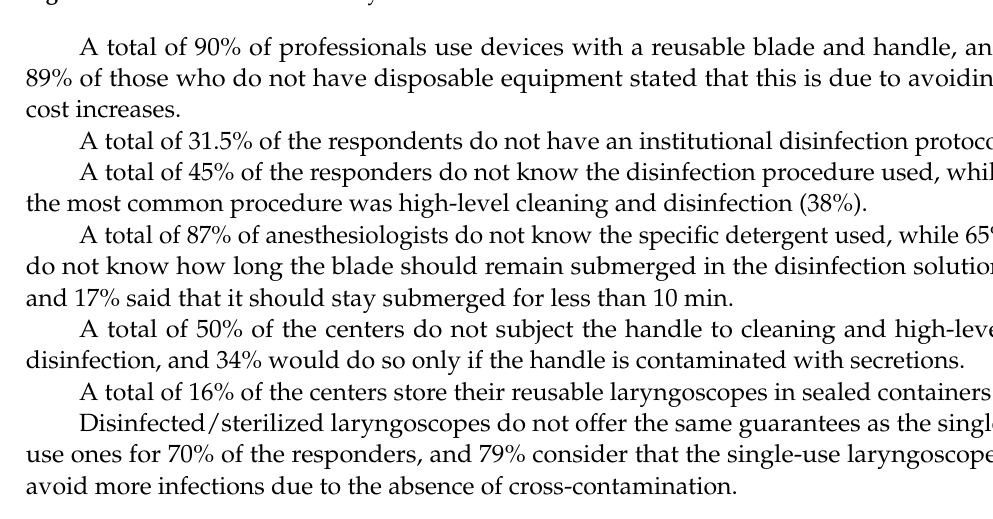
Figure 1. Main results of the survey.